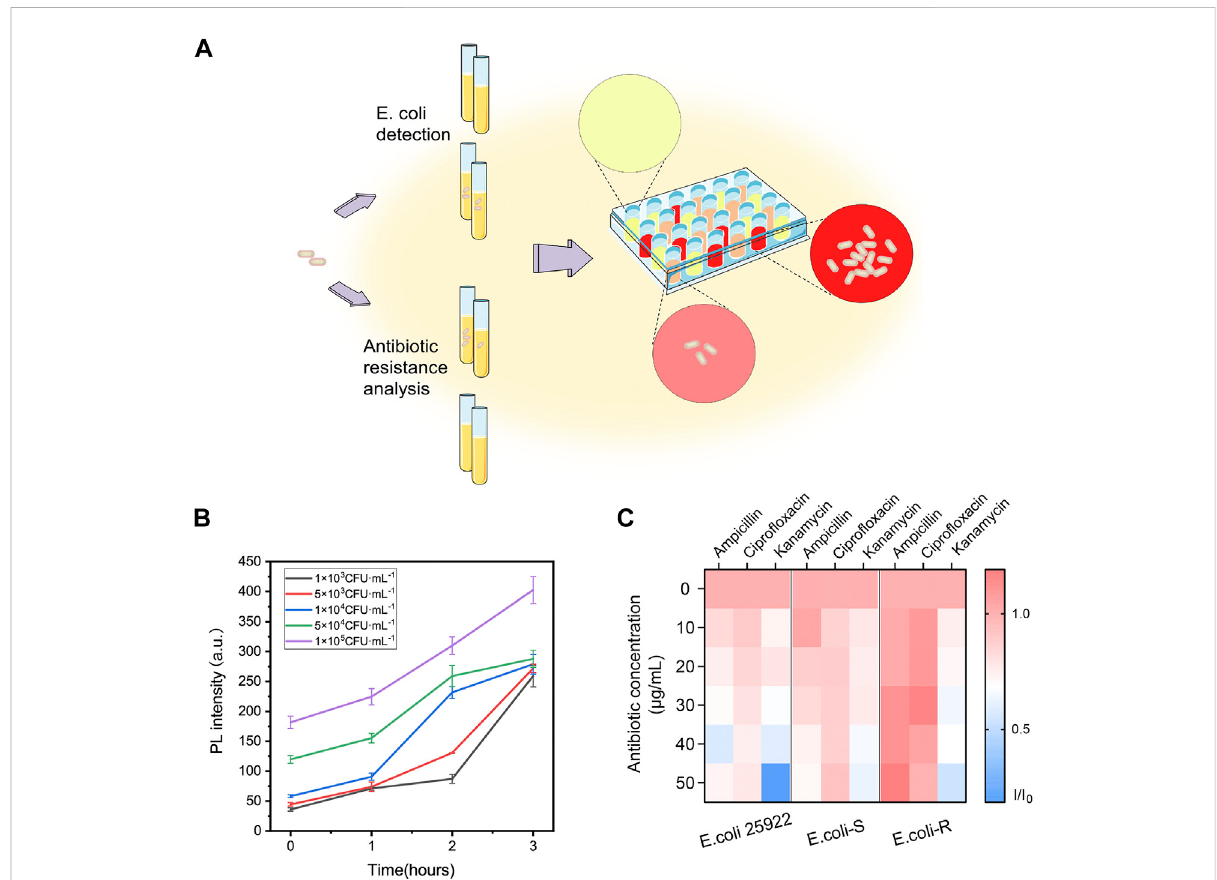
FIGURE 5 Two-step procedure for E. coli detection and high-throughput antibiotic screening using DCM- β gal based assay. (A) Schematic illustration of two-step procedure and high-throughput antibiotic analysis. E. coli cells are lysed to release intracellular β -gal and the signal generation based on enzyme-response is correlated with the concentration of E. coli cells. For antibiotic resistance analysis, E. coli cells can be treated with various antibiotic concentrationsand fl uorescenceratio ofreactionproductsin96-well plate canbehighthroughput monitored byCytation. (B) Two- step detection of E. coli at low concentrations using DCM- β gal based assay. PL intensity (675 nm) with detection time (0 – 3 h) toward E. coli concentration of 1 × 10 3 , 5 × 10 3 , 1 × 10 4 , 5 × 10 4 , and 1 × 10 5 CFU ml − 1 . Error bars indicate ± SD of triplicate measurements. (C) Heatmap plot of fl uorescence ratio (I/I 0 ) of three types of E. coli cells ( E. coli ATCC 25926, antibiotic-sensitive ( E. coli -S) and resistant E. coli ( E. coli -R) collected from clinical samples) toward various antibiotic